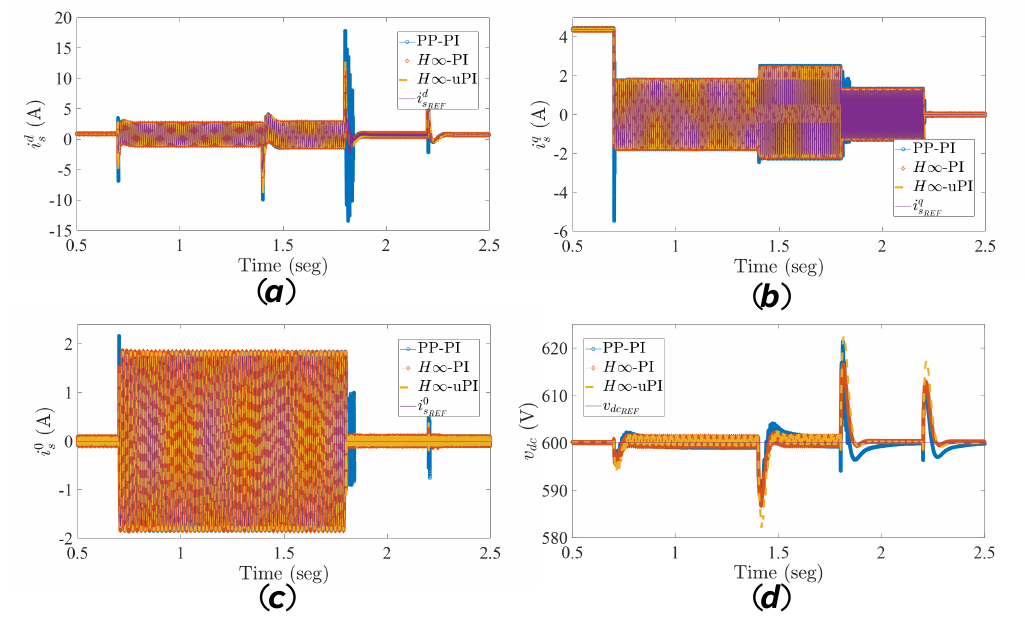
Figure 11. PI controllers’ dynamical performance comparison: ( a ) i d s , ( b ) i q s , ( c ) i 0 s , and ( d ) v DC .